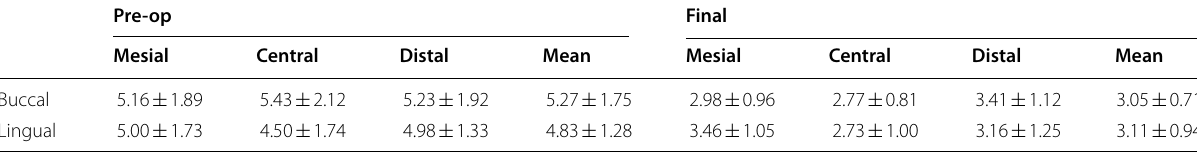
Table 2 Pre‑operative and final PPD at 6 sites around the observed implants (in mm) Pre‑op Final Central